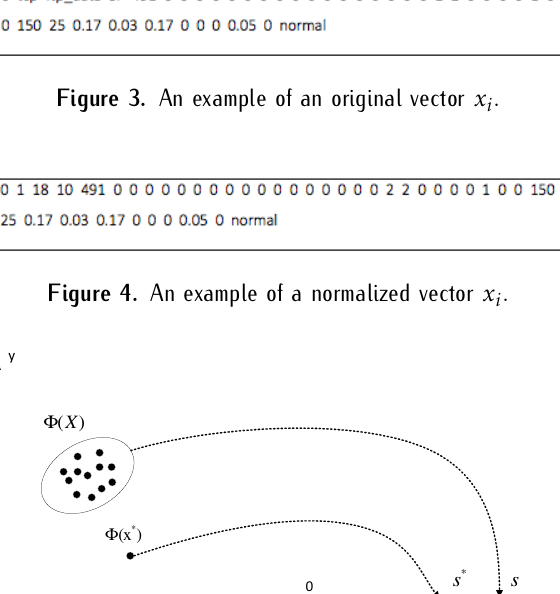
Table 1. Symbolic-typed Attributes